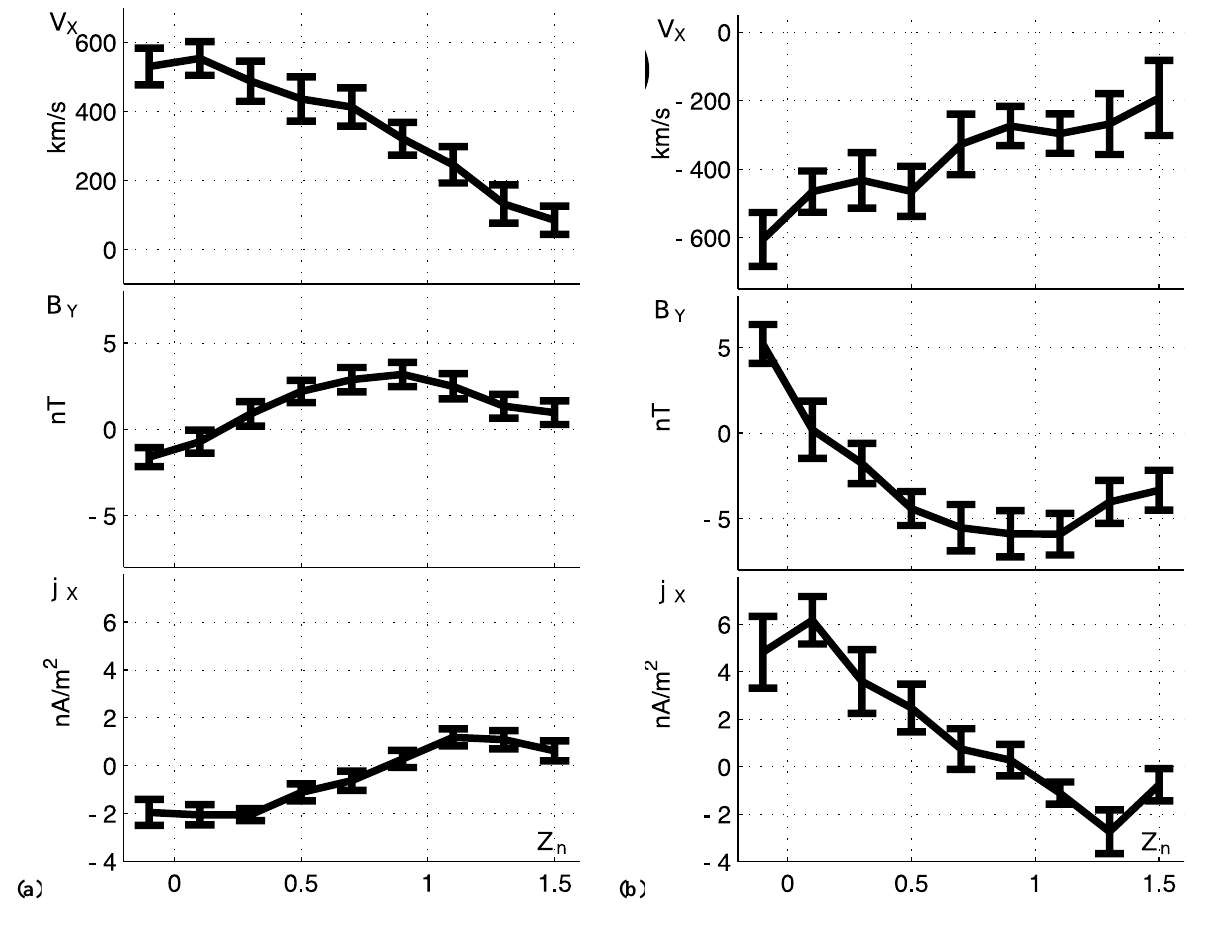
Fig. 4. The average patterns for earthward (a) and tailward (b) flows. Z n is the normalised distance from the centre of the current sheet. (a) and (b) are calculated from 43 and 20 current sheet coverages, respectively. One example of a current sheet coverage was shown in Fig. 3.